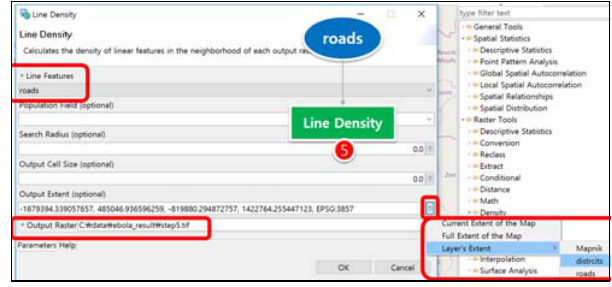
Figure 10. Parameters for Line Density